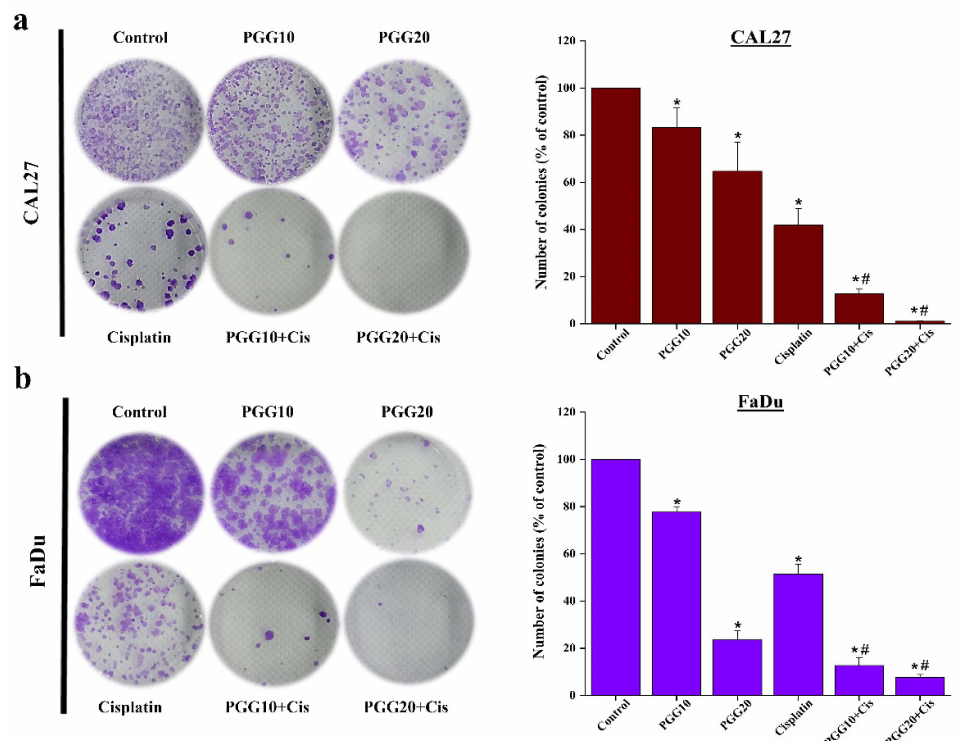
Figure 2. PGG enhances the role of cisplatin in survival of HNSCC cancer cells. Clonal survival analysis showed the number of colonies of CAL27 ( a ) and FaDu ( b ) cells after treatment with PGG (10, 20 µ g/mL), cisplatin (2 µ g/mL), or the combination of two drugs. Representative images are shown in the left panel, and quantification graphs are shown in the right panel. Data are expressed as (mean ± SD) of three independent experiments. * p < 0.05: significantly different from control, and # p < 0.05: significantly different from PGG and cisplatin treatment alone. PGG, pentagalloyl glucose; Cis,